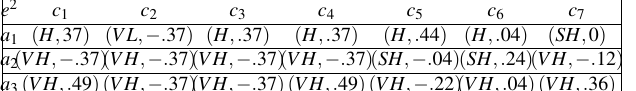
Table 6. Unified information provided by e 2 .